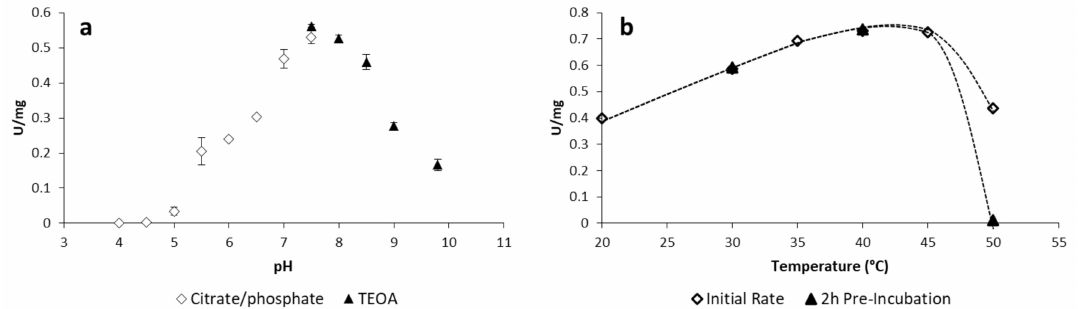
Figure 3. ( a ) A pH optimum of 7.5 was determined for Ec PDH E1 activity by the DCPIP assay (0.2 mM ThDP, 2 mM MgCl 2 , 2mM sodium pyruvate, 100 µ M DCPIP, 20 mM KPi, 25 ◦ C). ( b ) Ec PDH E1 displays a maximum activity at 40 ◦ C with no concomitant loss of activity after two hours. Higher temperatures swiftly reduce the initial rate and lead to a complete inactivation (0.2 mM ThDP, 2 mM MgCl 2 , 2 mM sodium pyruvate, 100 µ M DCPIP, 20 mM KPi, pH 7.5). Control reactions were performed in the absence of an enzyme.